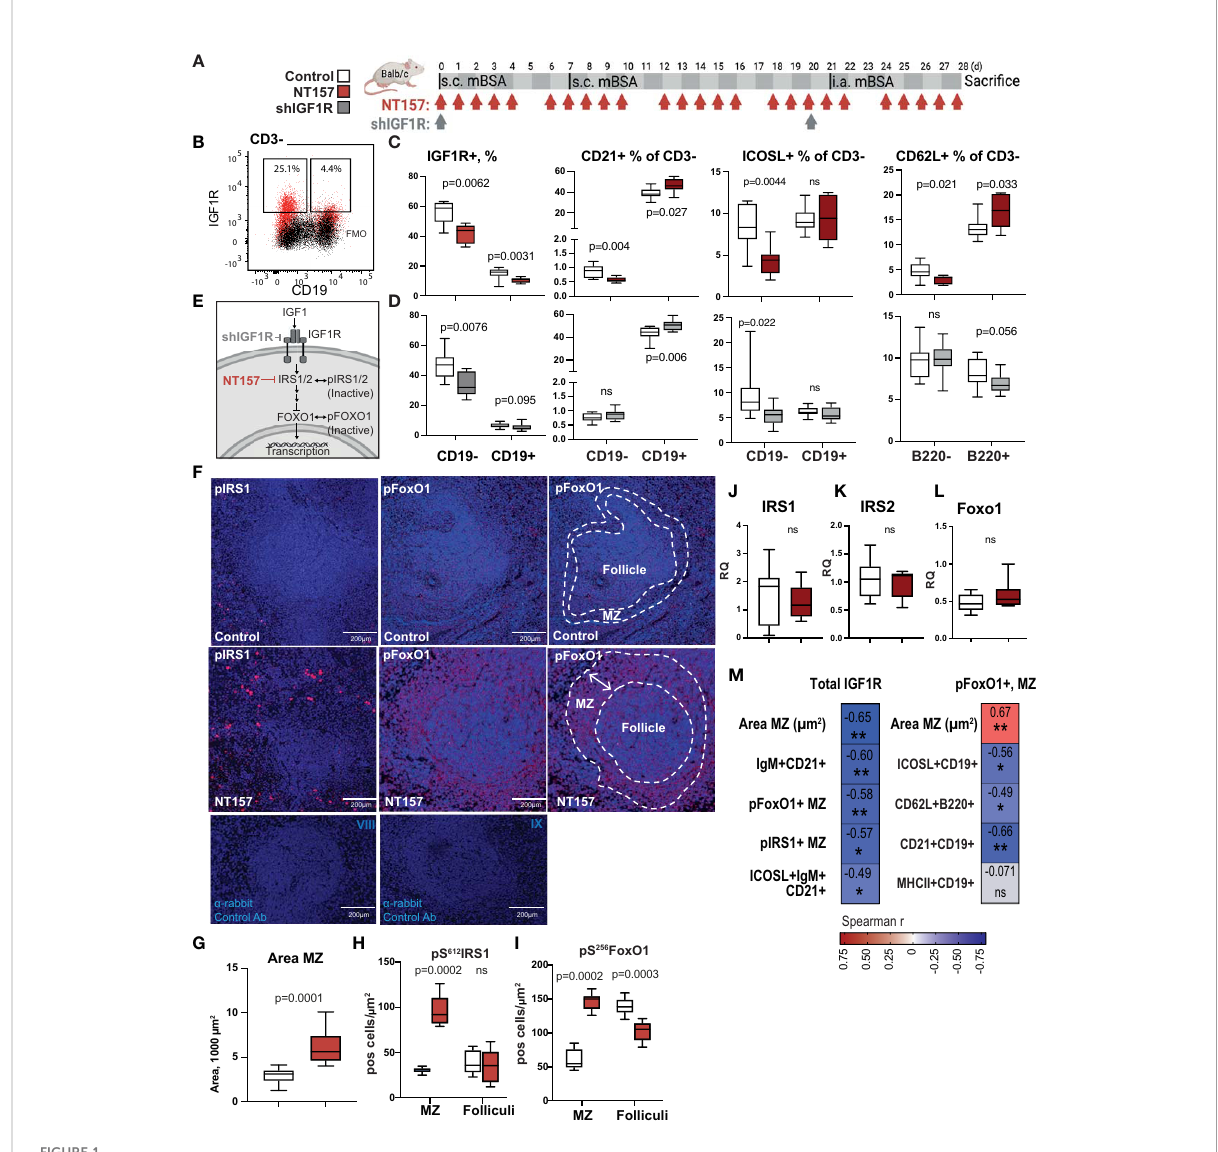
FIGURE 1 Enlargement of MZ following inhibition of IGF1R signalling. (A) IGF1R-targeting experimental setting using NT157 and shIGF1R treatment. (B) Flow cytometry gating strategy for IGF1R + subsets of CD19 - and CD19 + leukocytes in spleen. (C) Box plots of IGF1R + subsets in NT157-treated mice and (D) in shIGF1R-treated mice. (E) IGF1R signalling. (F) Confocal images of pS 612 IRS1 + and pS 256 FOXO1 + cells in MZ of control and NT157-treated mice. (G) Box plots of MZ area. (H) Box plots of pIRS1 + and (I) pFOXO1 + cell density in MZ and follicles. (J – L) Box plots of mRNA IRS1, IRS2 and FOXO1 levels in spleen of NT157-treated mice. (M) Correlation matrix for total IGF1R + cell frequency and area MZ, pFoxo1 + , pIRS1 + cells in MZ. Spearman correlation was applied. *p<0.05, **p<0.01; ns, not signi fi